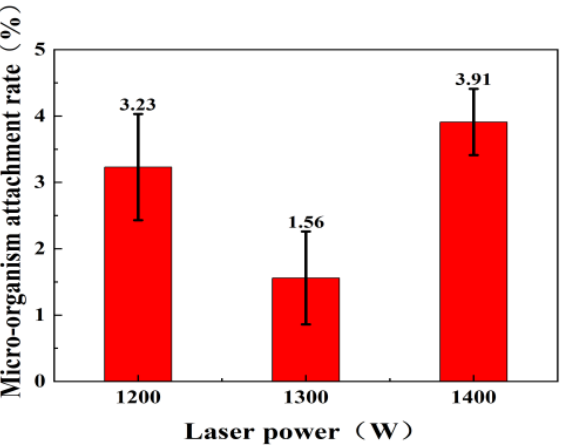
Figure 7. Micro-organism attachment rates of specimens No. 5 – 7.